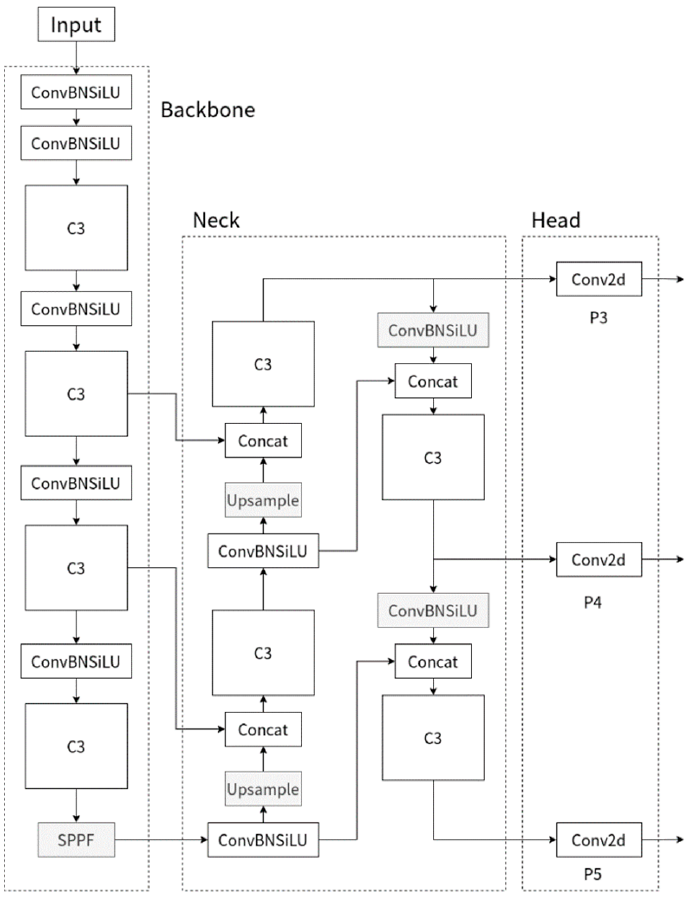
Figure 1. YOLOv5 algorithm structure diagram.